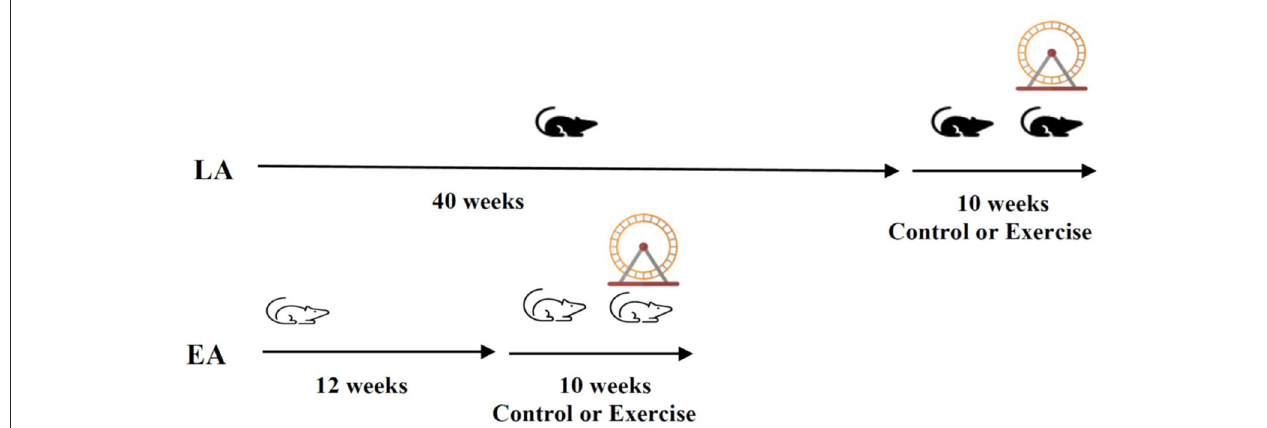
FIGURE 1 | Study protocol: Male apoE − / − mice on a chow diet ( n = 110 were randomly allocated to the late-stage or early-stage atherosclerosis group (LA; n = 65, EA; n = 38). They were further randomly allocated to control or exercise groups at 12 (EA) or 40 weeks (LA) of age for a further 10